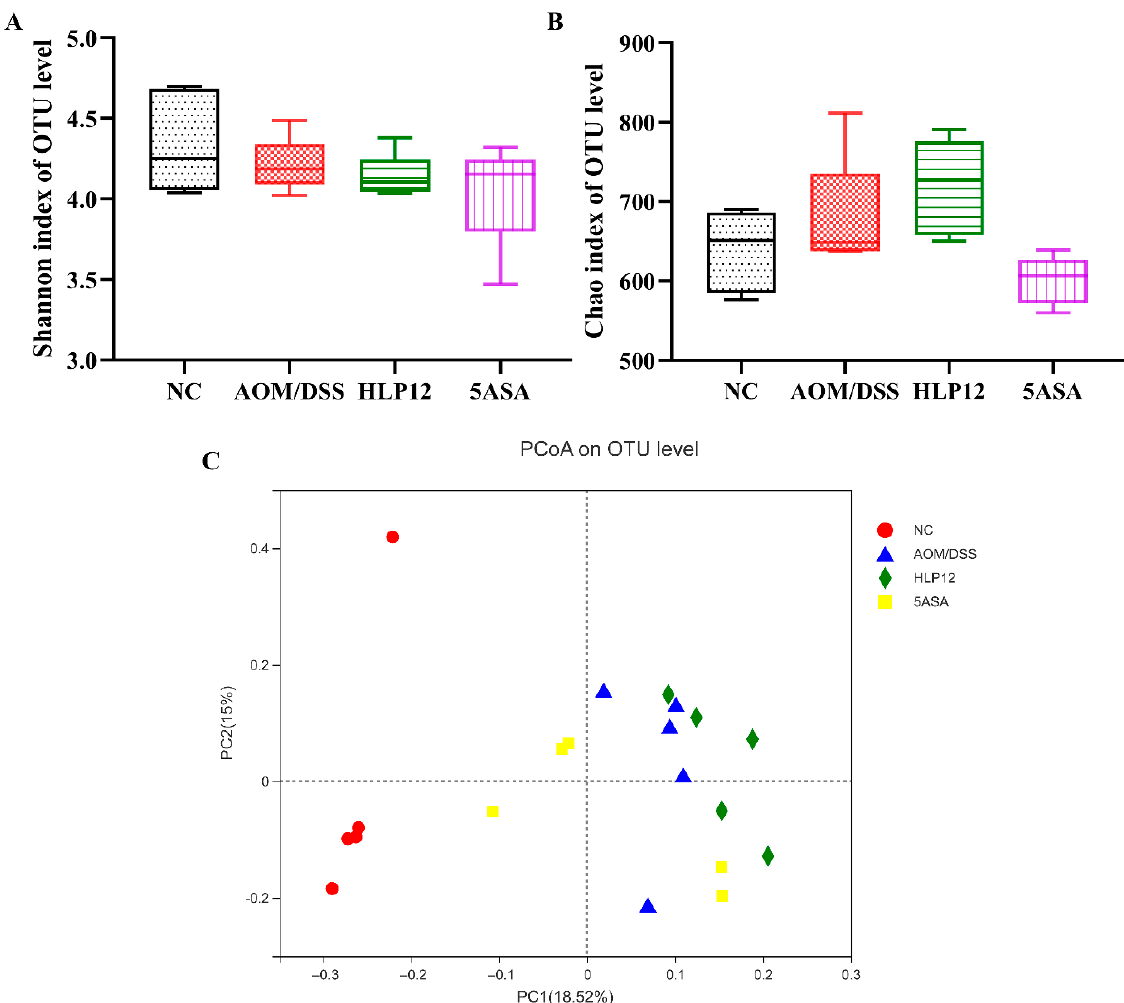
Figure 7. Effect of L. plantarum -12 oral administration on intestinal microbiota composition of the AOM/DSS-treated C57BL/6 mice ( n = 5). ( A ) Shannon index of identified OTUs, ( B ) Chao index of identified OTUs, and ( C ) PCoA